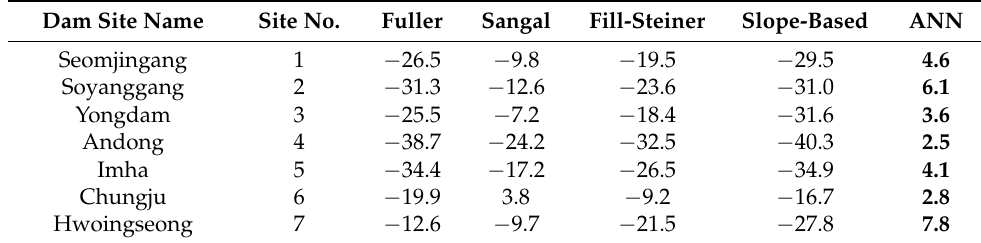
Table 6. Values of percent bias (Pbias, %) of the estimated peak flows with different